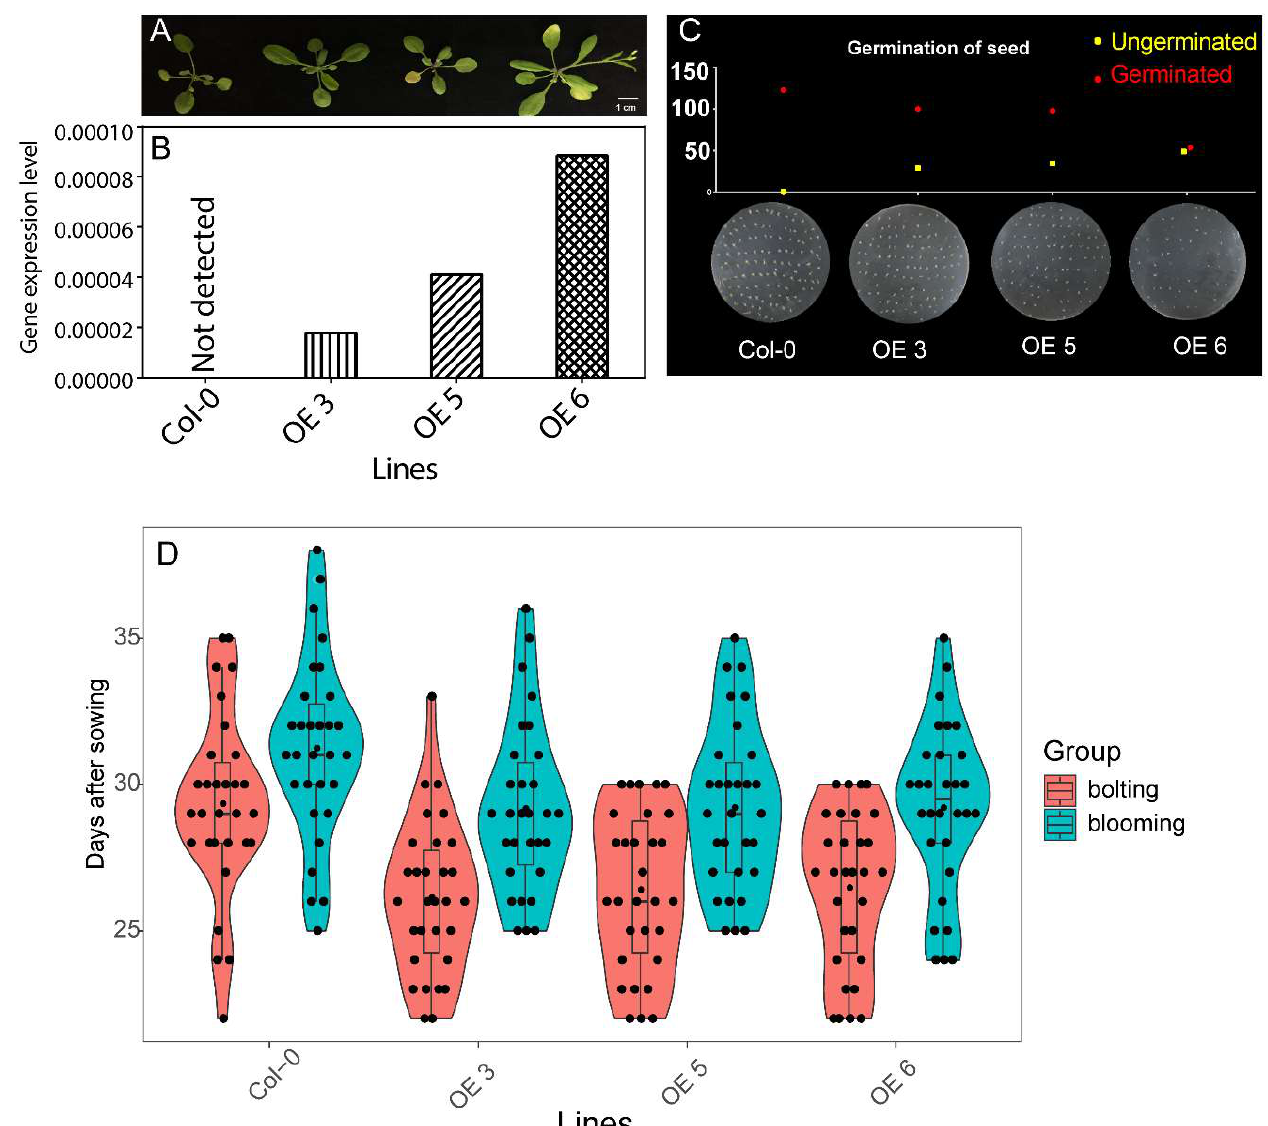
Figure 6. Phenotypes of 35S::CsFLC1 transgenic Arabidopsis thaliana . ( A ) Image of WT and OE-CsFLC1 lines. ( B ) CsFLC1 expression levels in different Arabidopsis thaliana lines. ( C ) Seed germination rates of different Arabidopsis thaliana lines. ( D ) Boxplot showing bolting and blooming times of different Arabidopsis thaliana lines: the bolting and blooming times were significant earlier in OE lines compared to WT, while there were no significant differences between OE lines.